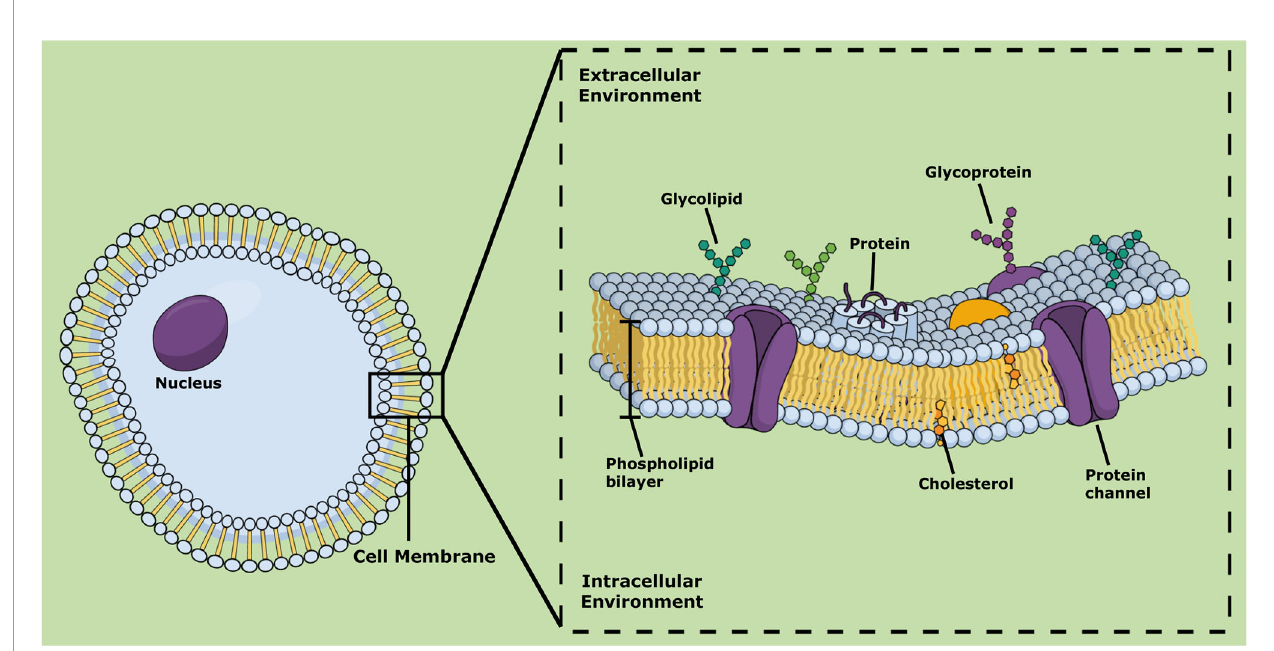
FIGURE 1 | Schematic representation of cell membrane showing its main chemical lipidic and protein